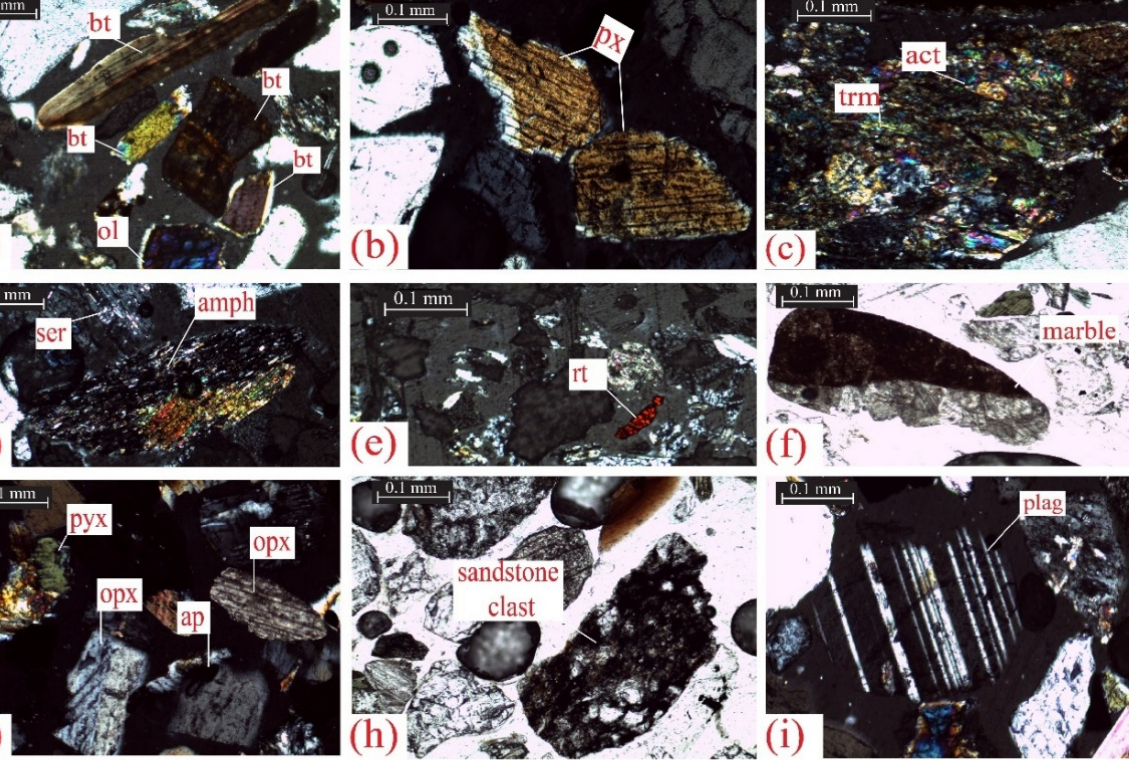
Figure 4. Microphotograph showing the average sediment composition of all the clusters ( a ) Biotite (bt), olivine (ol), ( b ) pyroxene (px), ( c ) actinolote (act) and tremolite (trm), ( d ) sericite (ser) and am- phibolite (amph), ( e ) rutile (rt), ( f ) marble clast, ( g ) pyroxene (pyx), orthopyroxene (opx), apatite (ap), ( h ) sandstone clast with hematite as cementing material, ( i ) plagioclase (plag), ( j ) pyroxene (pyx) with sphene (titn) inclusion, ( k ) quartz (qtz) with apatite (ap) inclusion and muscovite (ms), ( l ) olivine (ol) in the samples collected from the study area (scale 0.1 mm). The presence of feldspar, notably plagioclase albite and alkali feldspar, indicates a volcanic origin (Figure 4i). The alkali feld- spar, on the other hand, indicates a felsic igneous origin.